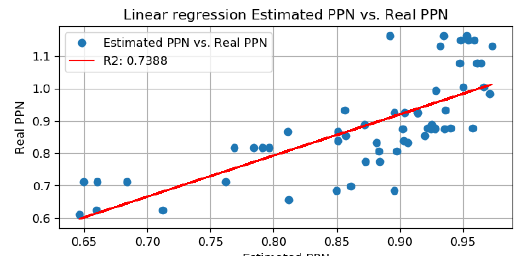
Figure 8. Lineal regression between Estimated PPN and Real